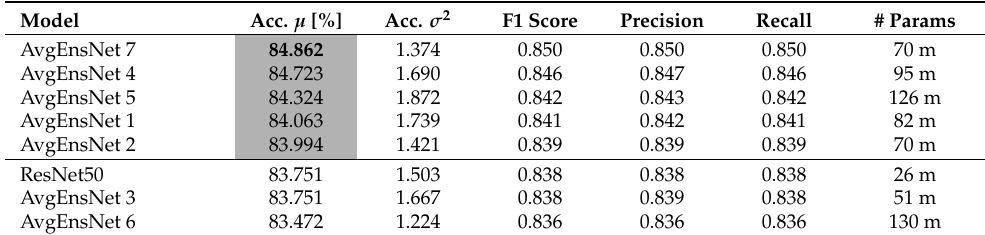
Table 4. Performance of the average ensemble models applied with the corresponding number of parameters.